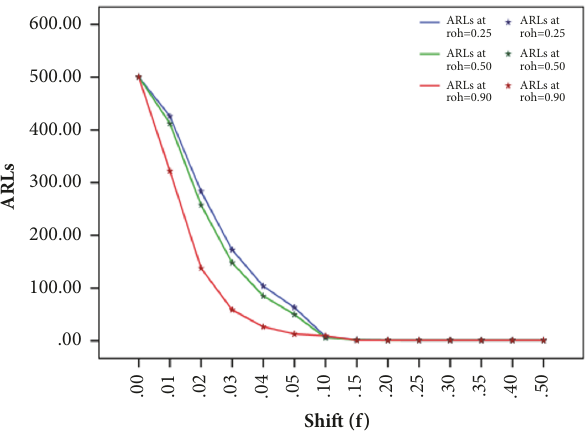
Figure 1: ARLs for proposed repetitive EWMA-RSS control chart using Bahl and Tuteja (1991) ratio estimator, when 𝑟 𝑜 = 500 at 𝜆 = 0.1.